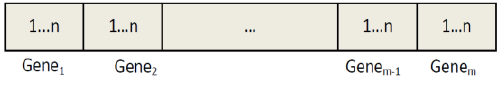
Figure 9. Chromosome